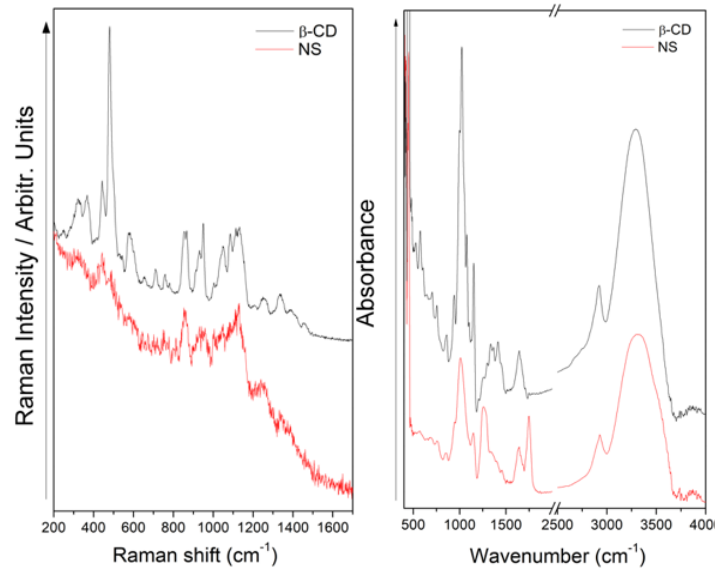
Figure 7. Raman ( left ) and FT-IR spectra ( right ) of β -CD and NSs. In the Raman spectral comparison, the disappearance and decrease in the relative intensity of some bands can be observed in the NSs profile, as a direct consequence of obtaining nanoparticles. The decrease in the relative intensity of the signal observed at 478 cm − 1 in the NS profile allowed for us to infer a vibration of the compound’s skeletal struc- ture, which was now restricted because of the new structure; the same can be stated for the signal observed at 950 cm − 1 . Related to this, the 576 cm − 1 band is absent in the Raman profile of NSs, being consistent with the observed spectral facts explained above. Finally, significant spectral data were observed in the FT-IR spectrum of NSs as a new band at 1755 cm − 1 , attributed to the C=O vibration. This signal confirms that we obtained the nan- osponge because of the presence of the C=O stretching from the linker. The ICs systems were also characterized by Raman and FT-IR. In this case, it is im- portant to mention that FT-IR spectra gave us more molecular information than Raman because the latter has a low cross-section, even more so considering the low molar con- centration of the CUR and MPH in each system. In the Raman profile of NSs–CUR (see Figure 8), a strong band observed at 672 cm − 1 and another signal with medium relative intensity located at 703 cm − 1 were ascribed to an out-of-plane deformation of the ring in CUR. However, the preparation of the NSs–CUR system was confirmed by the FT-IR spec- trum (see Figure 8) from the signals observed at 1446, 1408, and 949 cm − 1 , ascribed to in- plane deformation of − CH 3 groups, stretching of C=CH, and in-plane deformation of the ring, respectively. Furthermore, the interaction of CUR in the NSs is supported by addi- tional signals observed in the FT-IR spectrum at 2912, 3009, 3263, and 3378 cm − 1 .